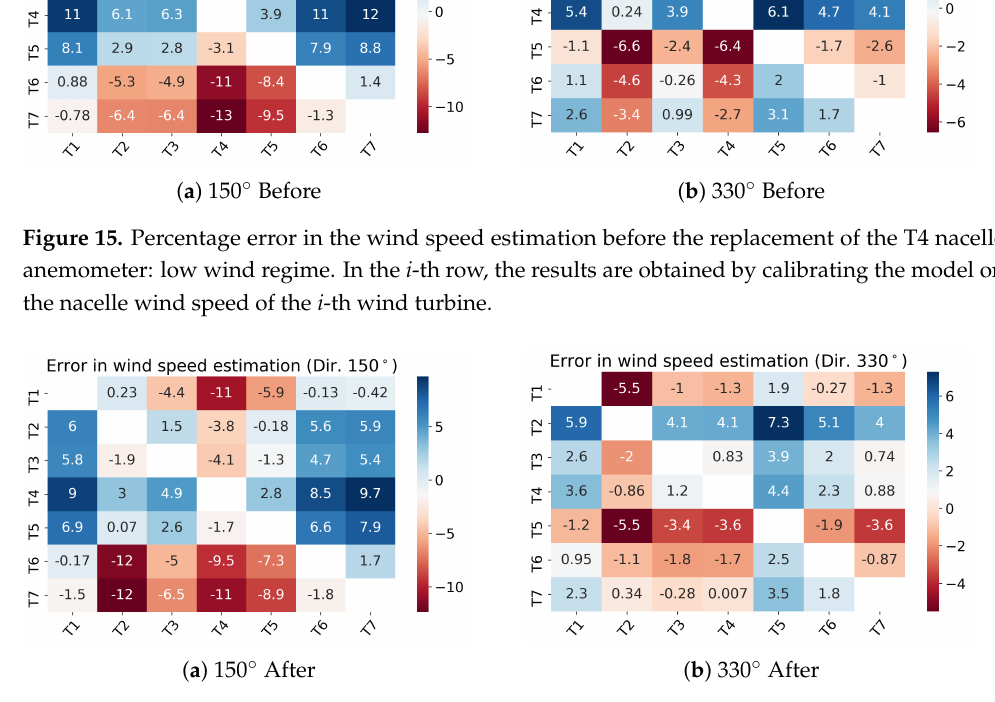
Figure 16. Percentage error in the wind speed estimation upon the replacement of the T4 nacelle anemometer: low wind regime. In the i -th row, the results are obtained by calibrating the model on the nacelle wind speed of the i -th wind turbine.